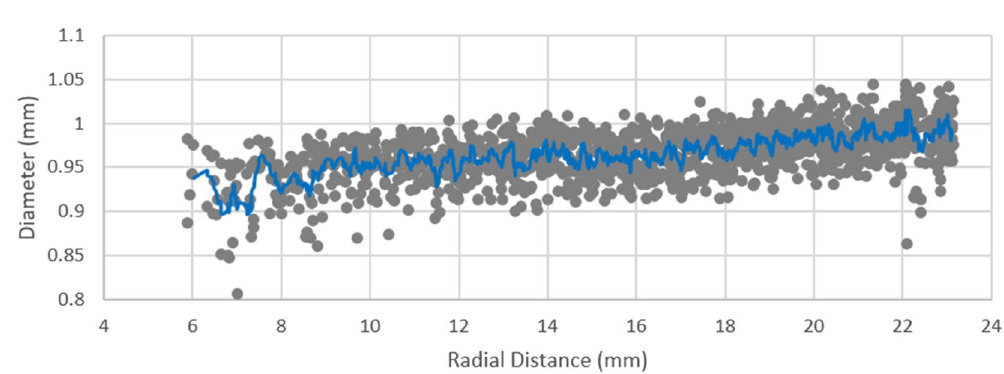
Figure 4. Fibre bundle movement as a function of temperature. ( a – c ) Relative movement of strands for section A2 of the heat-treated (HT) conductor. A colour scale is used to map and quantify the degree of movement between each step in temperature, with differences measured in mm. ( d – f ) Equivalent colour maps for the section B2 of a non-heat-treated (NHT) conductor.